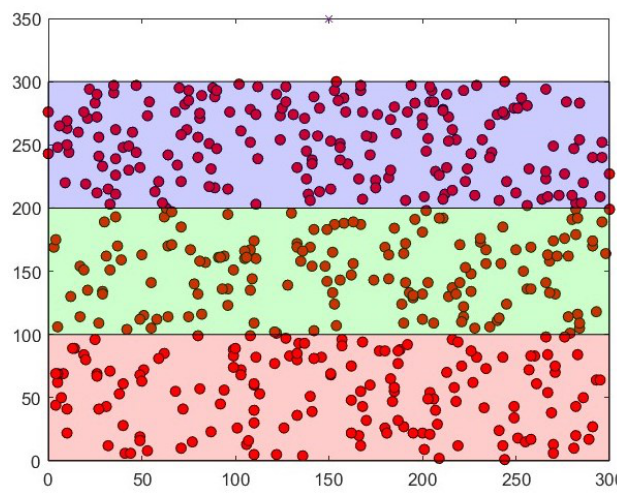
Figure 4. 500-Node model